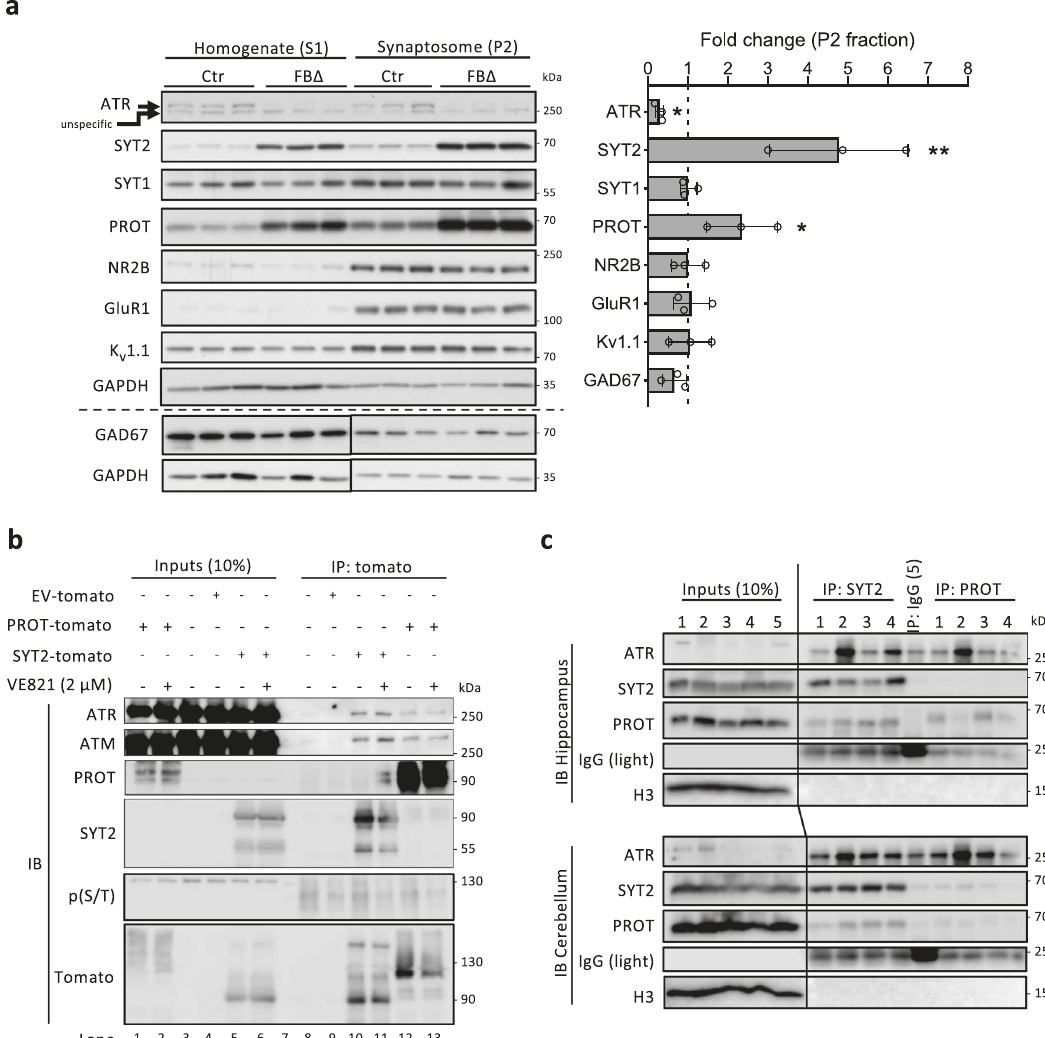
Fig. 8 ATR deletion upregulates presynaptic proteins SYT2 and PROT. a Western blot analysis of the indicated proteins in whole-cell extract (S1) and synaptosome (P2) fractions of 3-month-old hippocampus of control (Ctr) and ATR-FB Δ (FB Δ ) mice. GAPDH controls loading. Note, GAD67 expression is controlled by a separate control GAPDH below. The right panel shows the quanti fi cation of the indicated proteins after normalization with GAPDH. The data is represented as relative fold change in protein expression in P2 fraction, compared to control mice. N = 3 mice for each genotype. The vertical dashed line in the graph indicates control mice. Data are mean values ± SD. Student ’ s t -test (unpaired, one-tailed for ATR, SYT2 and PROT, two-tailed for others). P value: ATR, p = 0.025; SYT, p = 0.001; PROT, p = 0.029. * p < 0.05, ** p < 0.01. b ATR interacts with SYT2 and PROT in vitro. Murine neuroblastoma cells (N2a) were transfected with Tomato-SYT2 or Tomato-PROT treated with or without with 2 µ M ATR inhibitor VE-821. SYT2 and PROT were immunoprecipitated with Tomato antibody and blotted by indicated antibodies. The experiment was repeated four times. c Immunoprecipitation of protein extract from hippocampi and cerebella using antibodies as indicated. IP against IgG serves as control. Histone H3 serves as loading control for the inputs. IgG light chain was used to control the amount of antibodies used for IP. Note, an overloading of IgG in IP-IgG lanes correlates with unspeci fi c binding signals in these samples. The number indicates individual mice. The experiment was repeated twice. Source data are provided as a Source Data fi